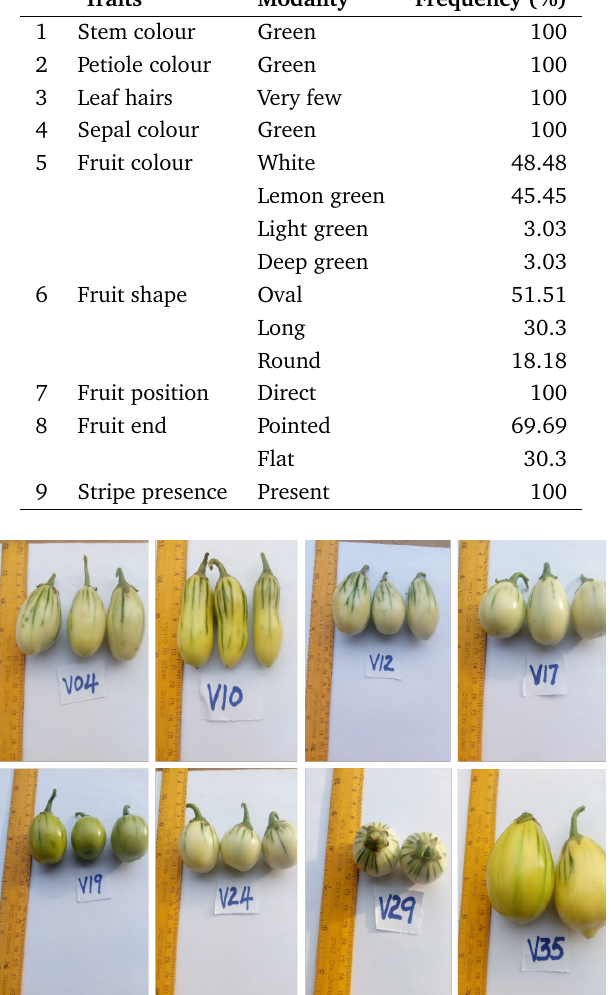
Figure 1. Sample of fruits for selected eggplant accessions, where V04, V10, V12, V17, V19, V24, V29 and V35 rep- resent NHEPA4, NHEPA10, NHEPA12, NHEPA17, NHEPA19, NHEPA24, NHEPA29 and NHEPA35 respectively.